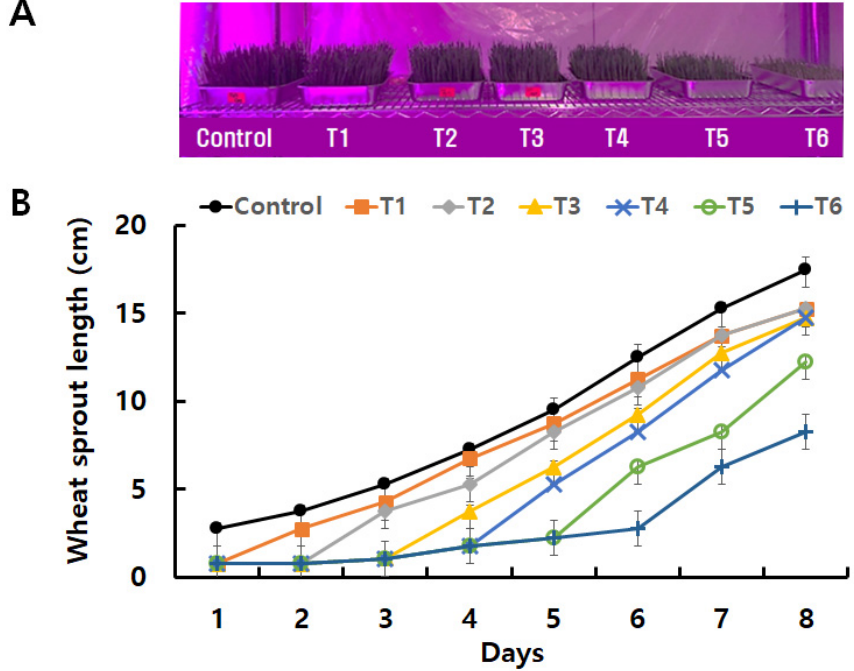
Figure 3. ( A ) Growth of purple wheat sprouts on day 8, and ( B ) sprout growth trends throughout the low ‐ temperature treatment period (T1–T6). Control, untreated control; T1–T6, number of days at low temperature (<4